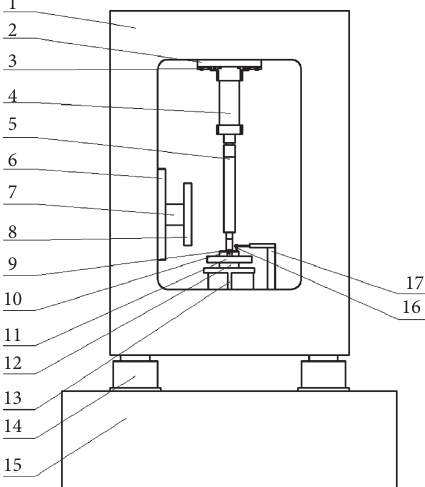
Figure 12: Schematic diagram of the overall structure for the test platform. Figure